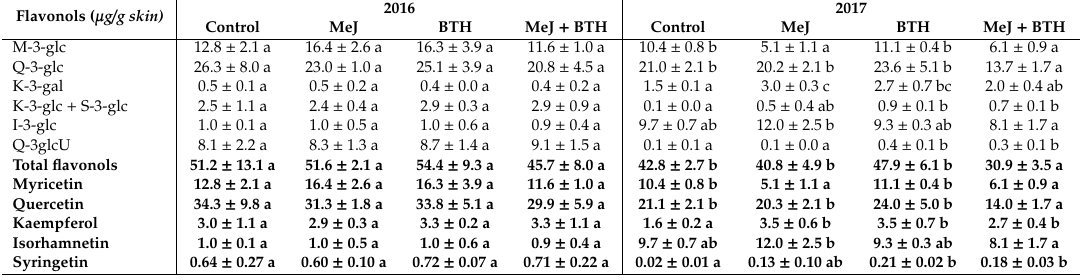
Table 3. Concentration of flavonols by HPLC in Monastrell grape berry skin treated with MeJ, BTH and MeJ +